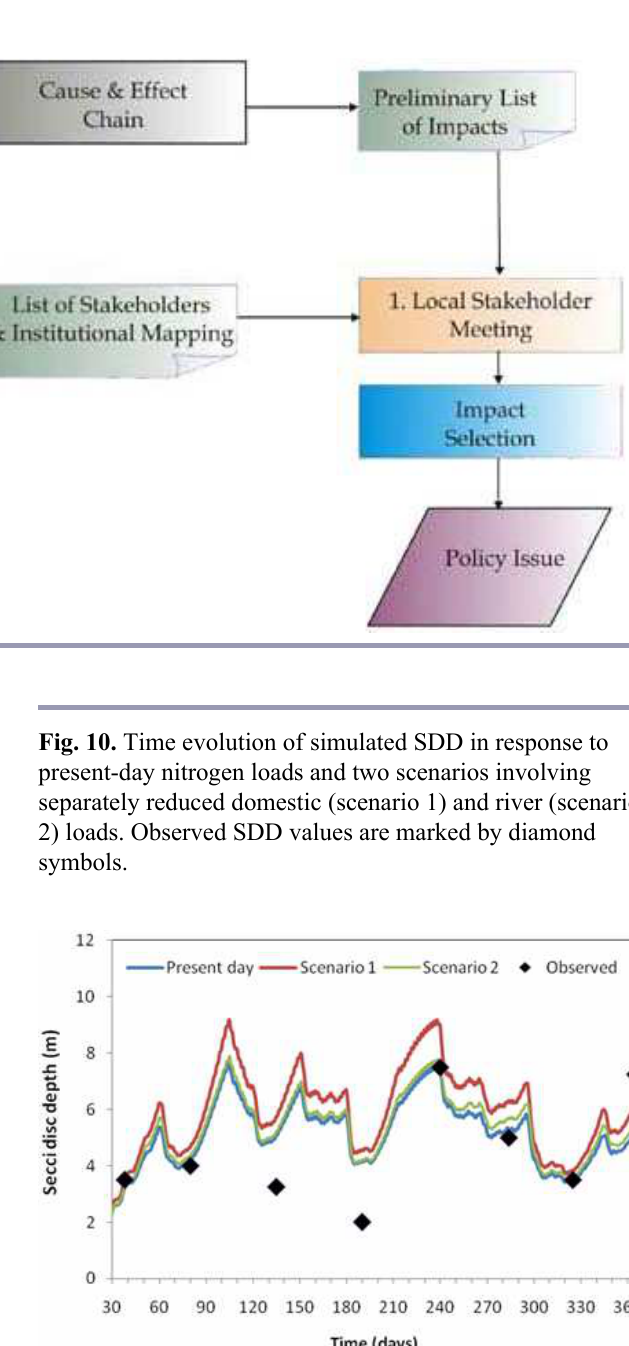
Fig. 9. A diagram depicting the method followed to determine the Policy Issue.